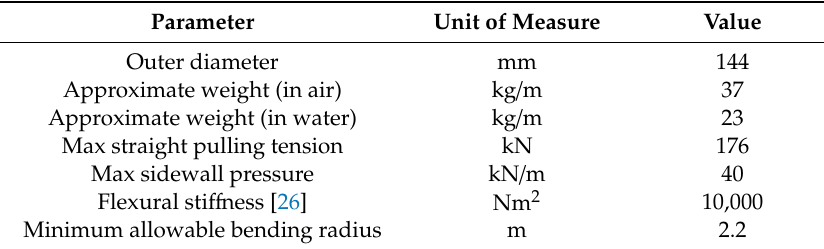
Table 1. Cable mechanical